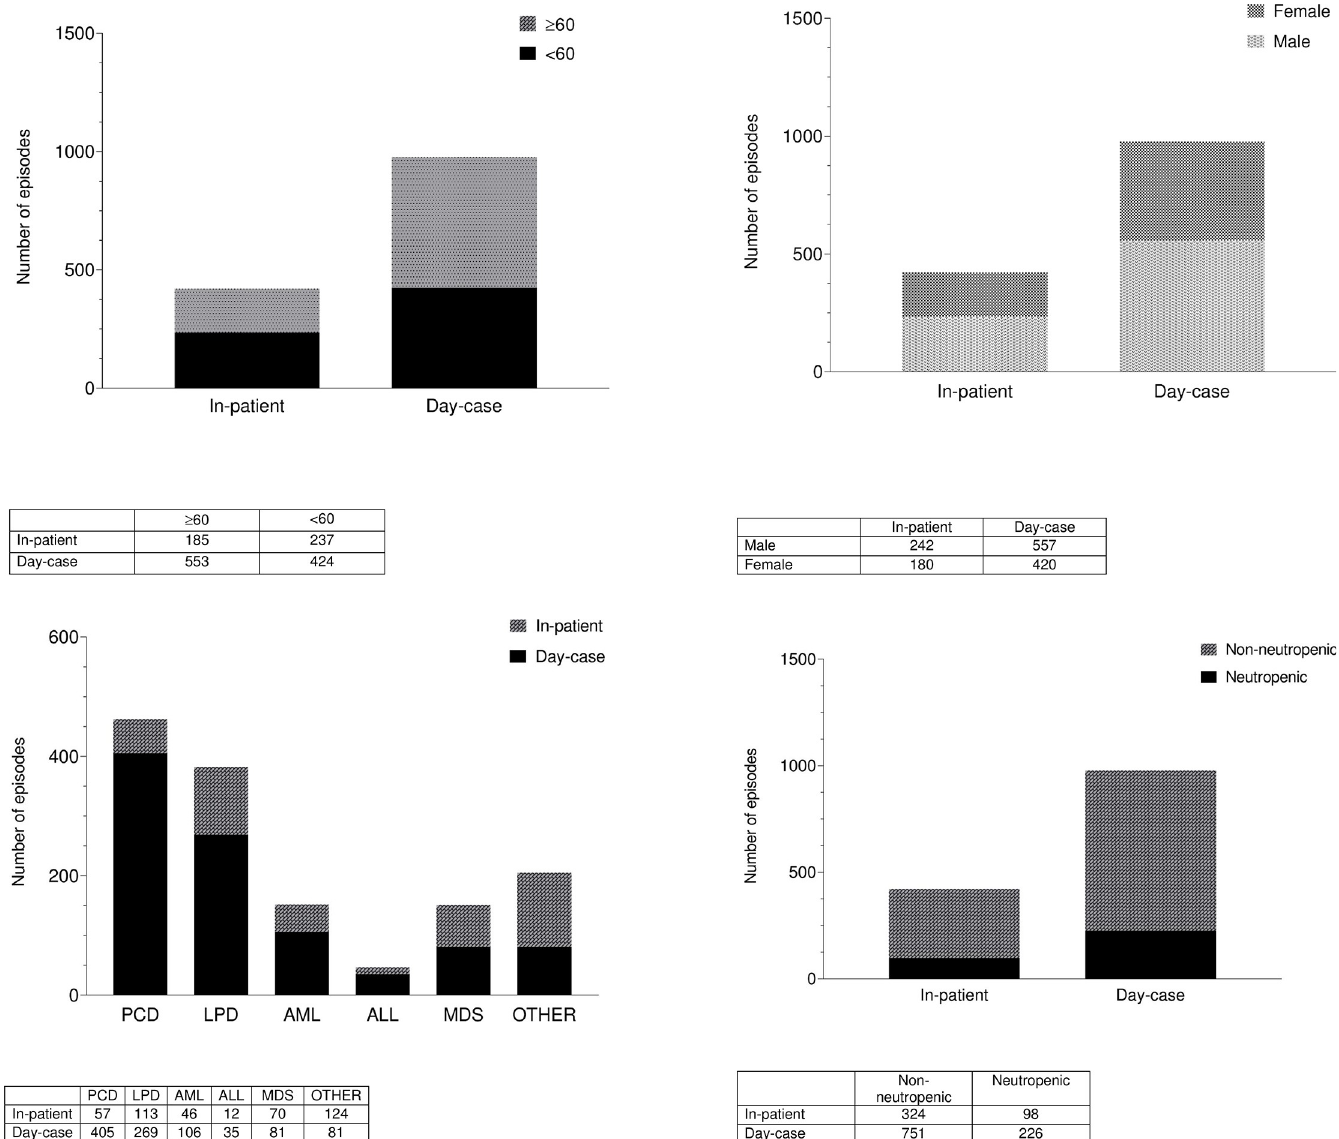
Fig 1. Patients reviewed as in-patient and as day-case according to A) age, B) gender, C) disease type and D) neutrophil count.